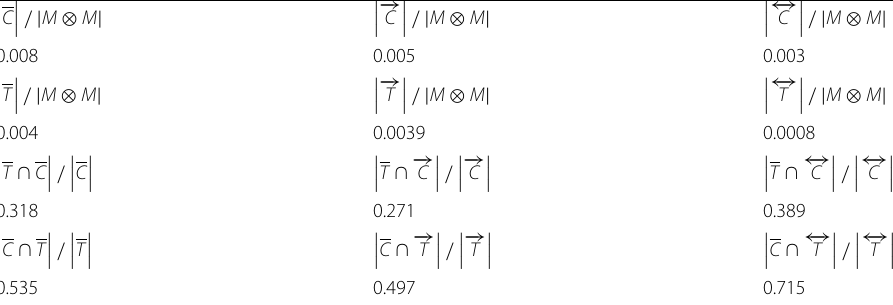
Table 1 Repartition of interactions among the sets defined by Eqs. 1 - 6 (cid:6)